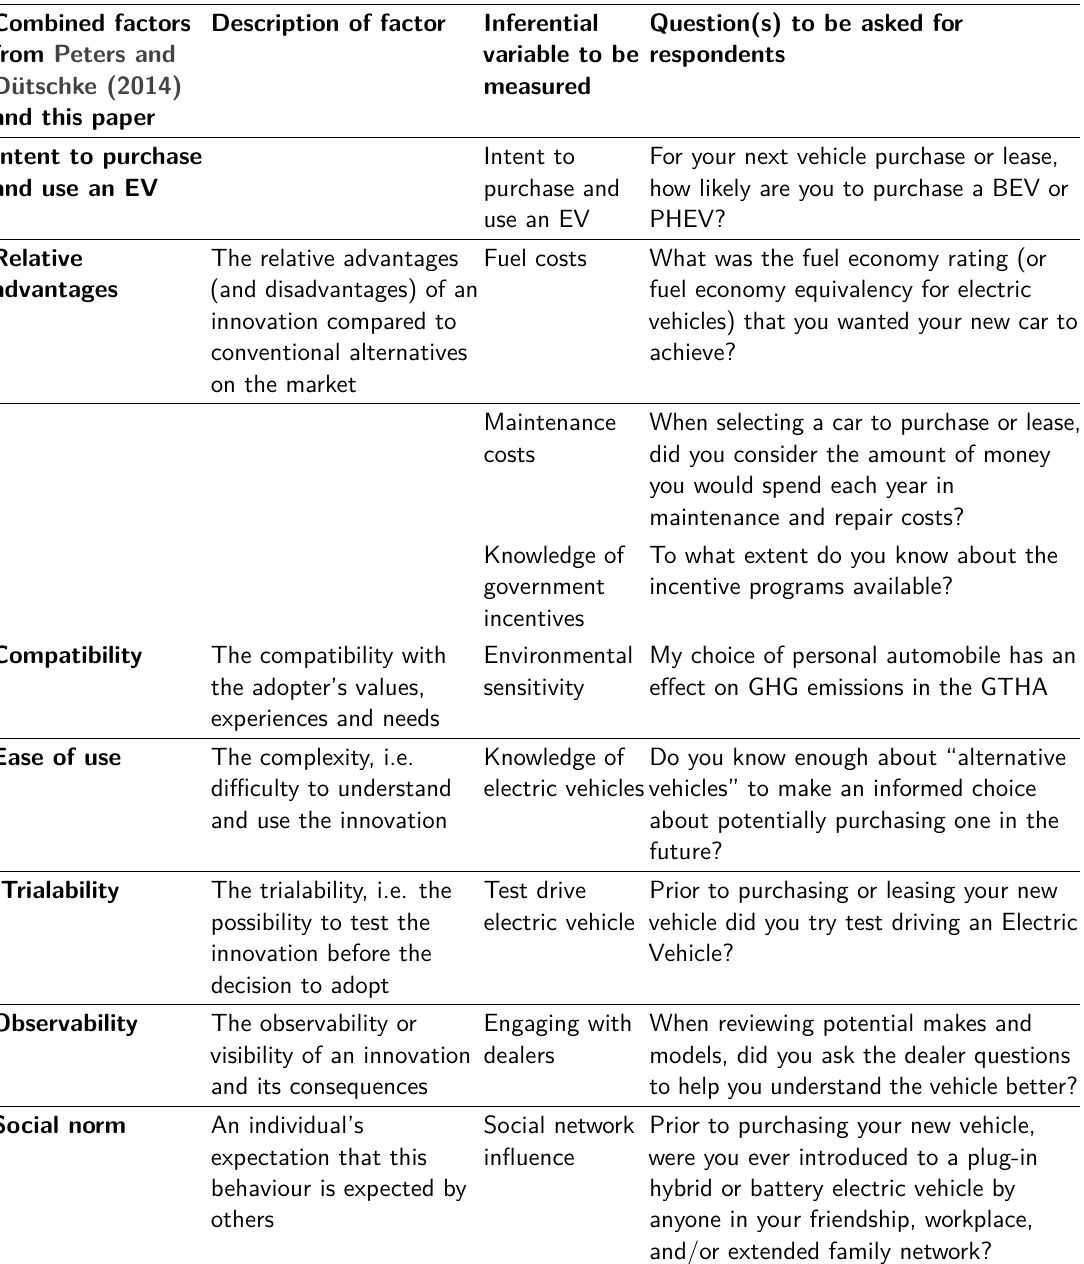
Table 1 . Summary of literature support for variable identification and Question development for